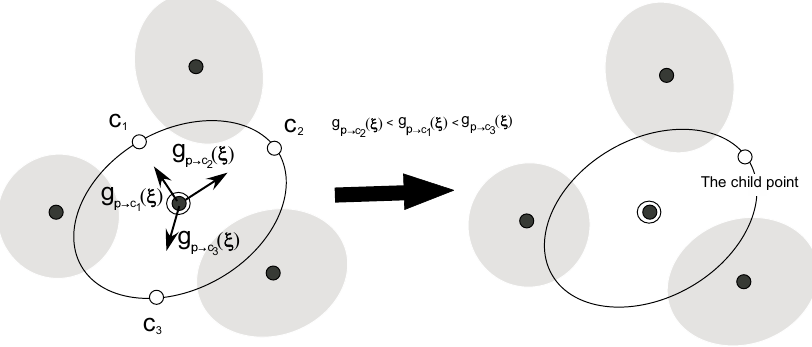
Figure 4. The determination step (step (4)) of the child point. First, we estimate the gradients along the directions from the parent point to candidate points as shown in the left side of the figure. Then, we choose the candidate point to which the direction is steepest descent as the child point as in the right side of this figure.